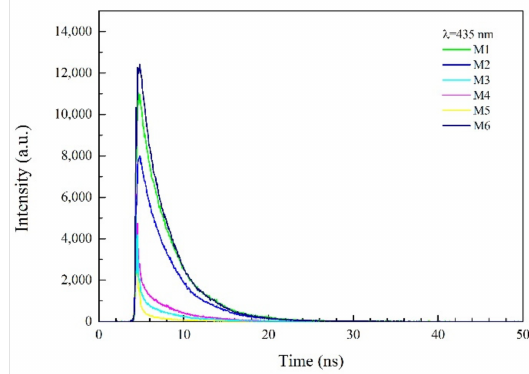
Figure 3. Figure 3 . Fluorescence decay curves of AFB1 and CdSe / ZnS QDs mixture with the di ff erent of the ratio of AFB1 concentration (excited wavelength: 405 nm; emission wavelength (435 nm).